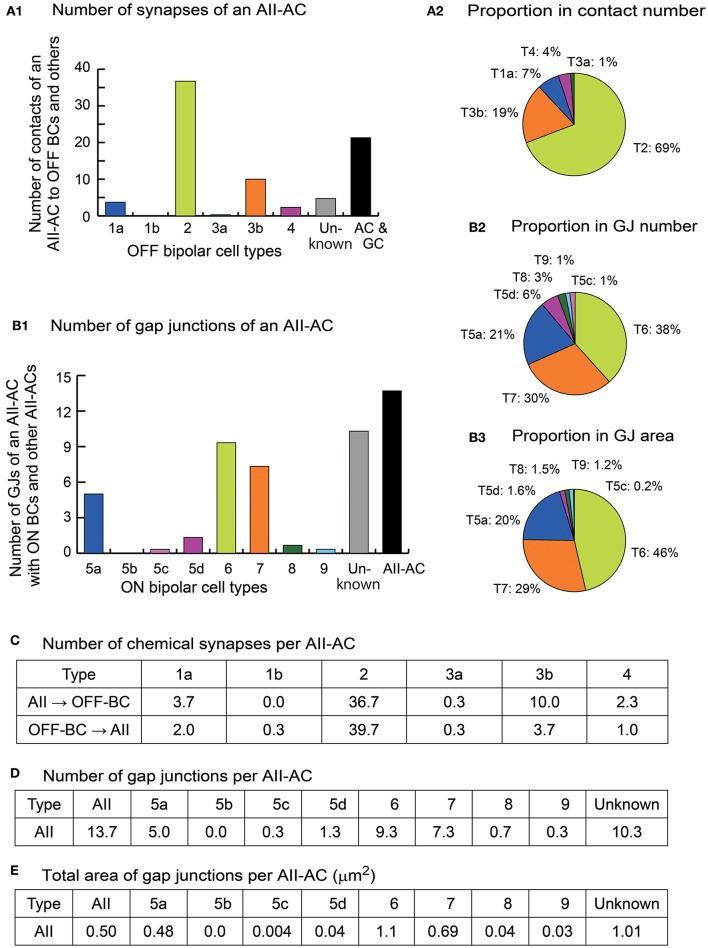
Type-dependent weighted outputs to bipolar cells from AII amacrine cells (AII-ACs). (A-1) The mean number of conventional synapses for output to different types of OFF bipolar cells, other amacrine cells, and ganglion cells per AII-AC (n = 3). (A-2) A pie chart showing the proportion of synapses to different types of bipolar cells. (B-1) The mean number of gap junctions with different types of bipolar cells and other AII-ACs per AII-AC (n = 3). (B-2) A pie chart showing the proportion of gap junctions with different types of bipolar cells. (B-3) A pie chart showing the proportion of gap-junction area with different types of bipolar cells. (C) The number of chemical synapses of AII-ACs and OFF bipolar cells per AII-AC. (D) The number of gap junctions of AII-ACs and ON bipolar cells per AII-AC. (E) The total area of gap junctions of AII-ACs and ON bipolar cells per AII-AC.